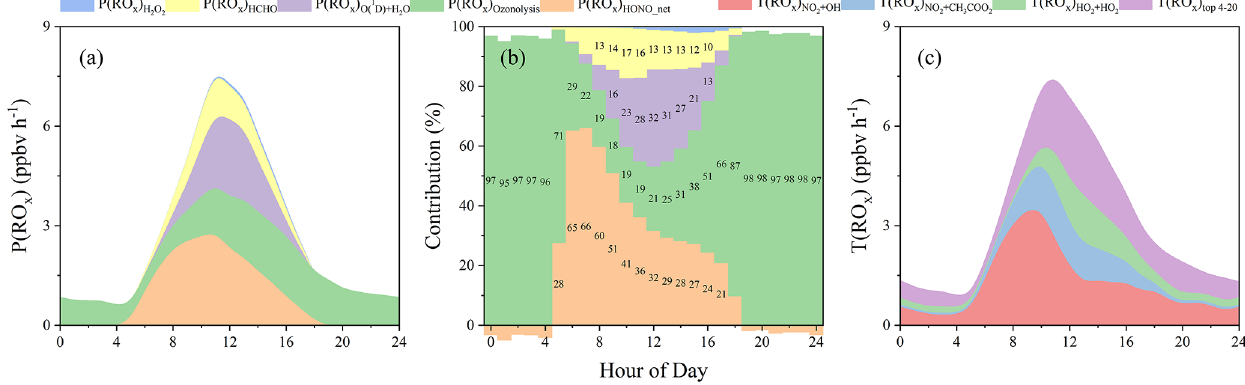
Figure 14. Primary RO x production and net RO x loss. (a) Production from different sources and (b) their relative contributions at different hours of the day. (c) The top 20 RO x loss rates. Note that the top 20 net radical loss paths are summarized here. It could represent the majority of total T (RO x ) as others ( < 0 . 03ppbvh − 1 ) were at least 2 orders of magnitude lower than the sum of the top 20. Nighttime P (RO x ) HONO_net was negative (a net sink for OH), so that its contribution was also negative at night. The same amounts of radical loss or production from equilibrium reactions (e.g., HO 2 + NO 2 ↔ HNO 4 ; CH 3 COO 2 + NO 2 ↔ PAN) were excluded from radical initiation or termination. T (RO x ) NO represents the net PAN 2 + CH 3 COO 2